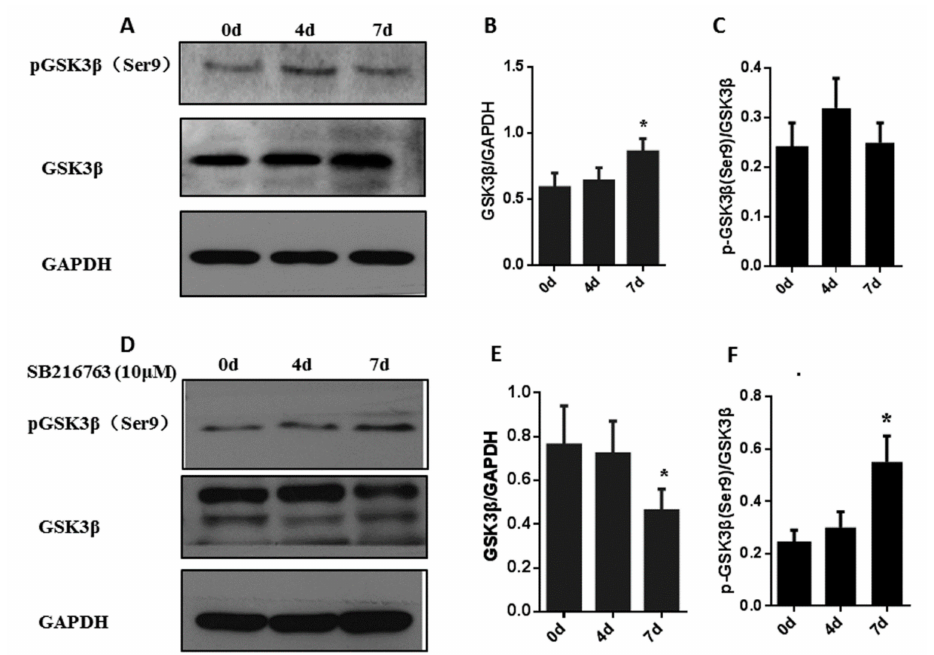
Figure 3. SB216763 a ff ects the level of pGSK3 β (Ser9) and GSK3 β in muscle satellite cells. ( A , B , C ) Representative western blots and quantified results of pGSK3 β (Ser9) and GSK3 β during adipogenic di ff erentiation in muscle satellite cells for 0, 4 and 7 days. ( D , E , F ) Representative western blots and quantified results of the levels of pGSK3 β (Ser9) and GSK3 β in muscle satellite cells treated with SB216763 for 0, 4 and 7 days. Error bars represent the SEMs of three separate experiments. ** p < 0.01; * p < 0.05 relative to 0 d